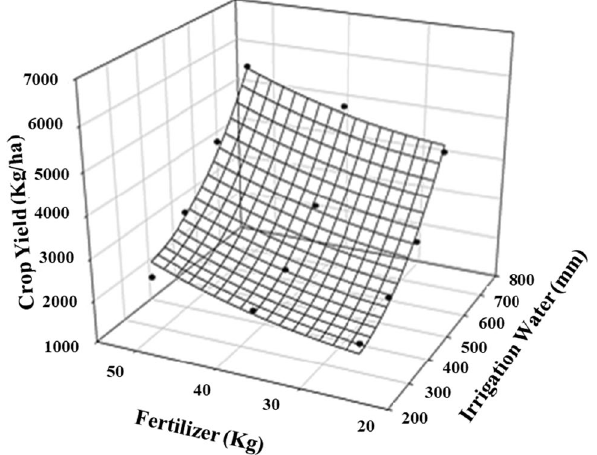
Fig. 12 The slope of crop yield changes in the field (dry leaves) in kilograms per hectare under simultaneous water-salinity-nitrogen stress